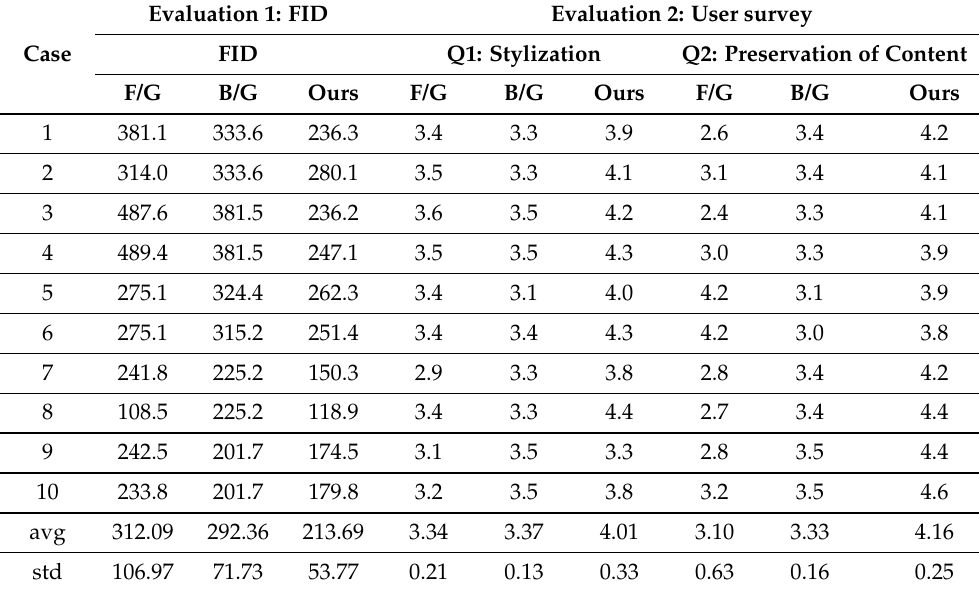
Table 2. FID values and user survey scores (F/G denotes foreground, and B/G denotes